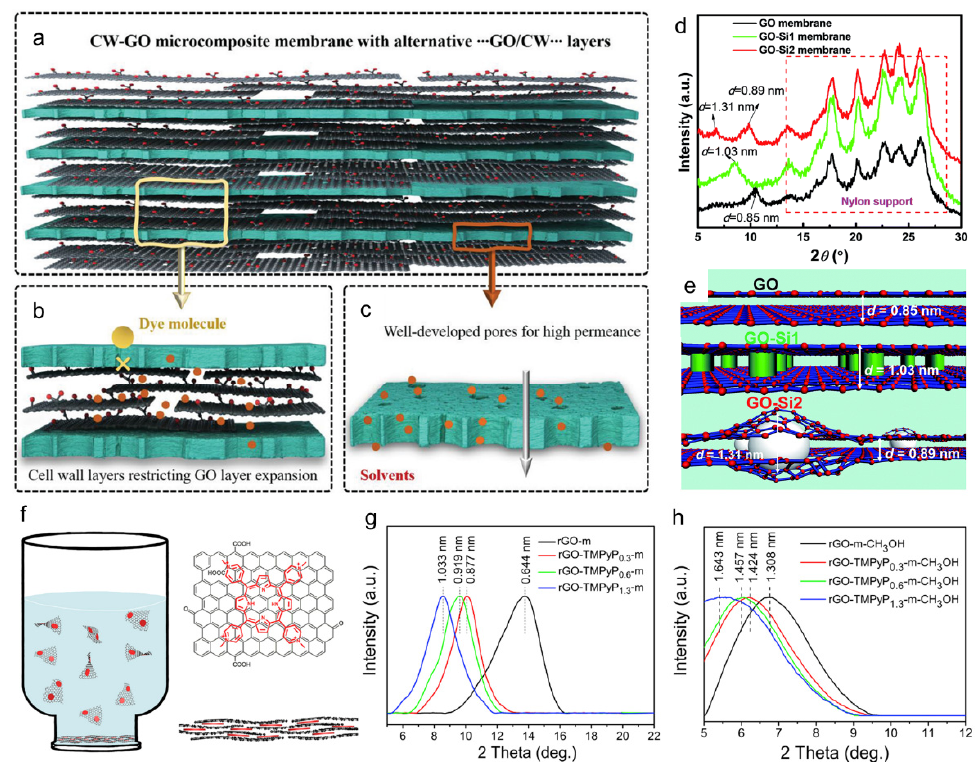
Figure 8. Graphene-based hybrid membranes ( a – c ) Schematics of the CW-GO microcomposite membrane structure and the working principle of the CW layer between GO layers and CW layer itself [53]. Copyright 2021 Wiley. ( d ) XRD patterns and ( e ) schematic of the GO-Si hybrid membranes, showing the different interlayer spacings [54]. Copyright 2019 Royal Society of Chemistry. XRD patterns of the rGO-m and rGO-TMPyPn-m membranes at ( f ) dry state and ( g ) solvated state in methanol. ( h ) Schematic of the fabrication of an rGO-TMPyPn-membrane with molecularly modulated nanochannels [56]. Copyright 2017 Elsevier.